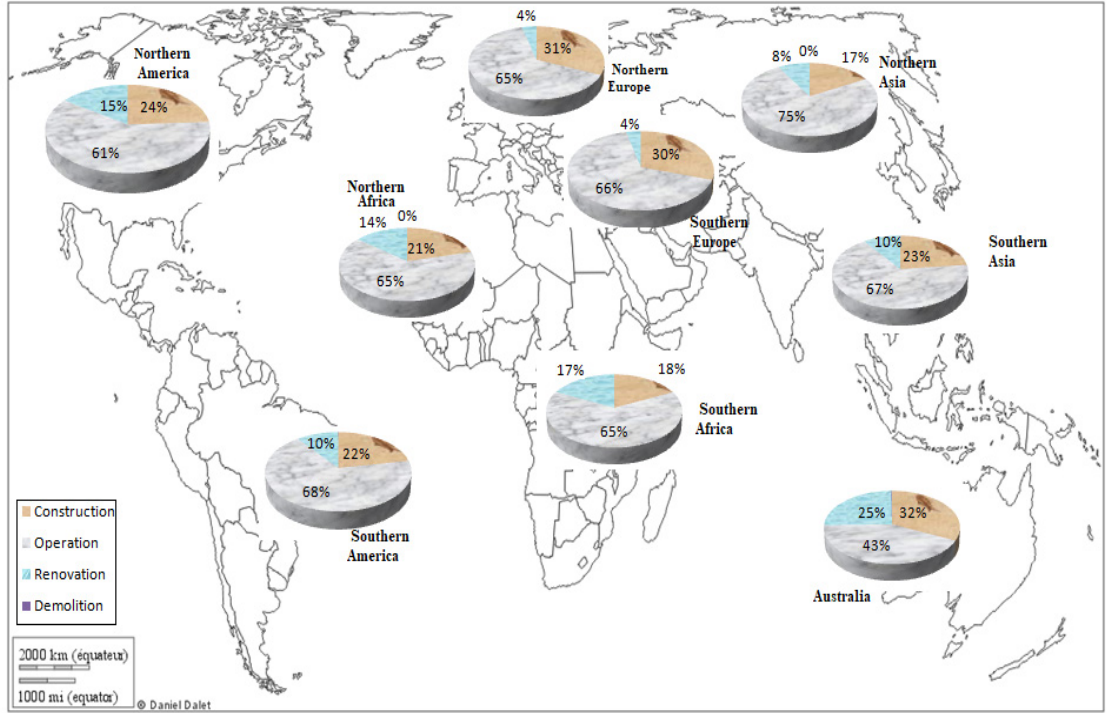
Figure 2. Distribution of eutrophication potential of different phases of the sustainable neighborhood in several world regions.